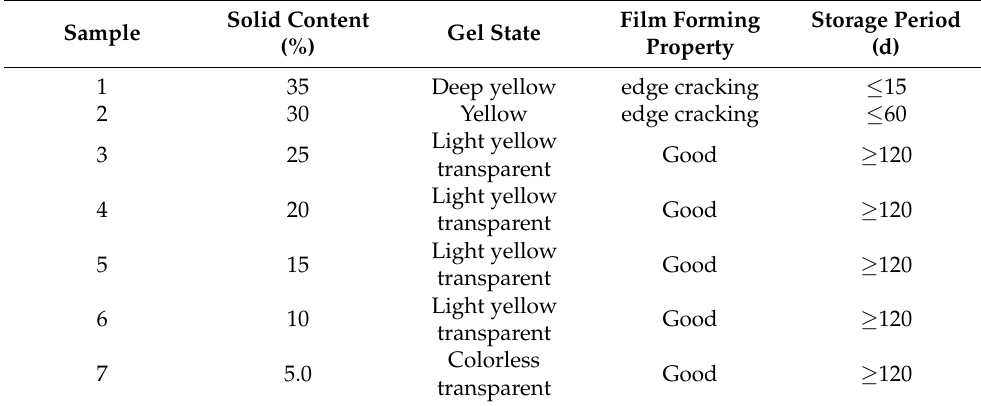
Table 1. Coating liquid storage and film forming performance.